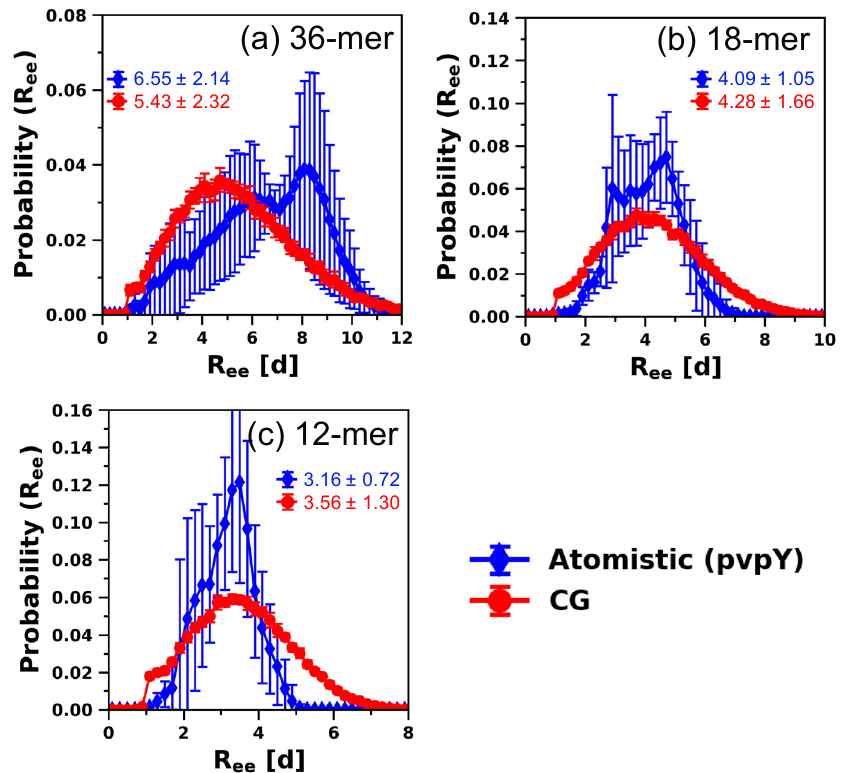
Figure 7. Comparison of distributions of R ee distance (with ensemble average values in reduced units (d)) for ( a ) 36-mer, ( b ) 18-mer, and ( c ) 12-mer pvpY chains, obtained from atomistic simulations and CG simulations (for the best performing case of attractive interaction between any two backbone beads (B–B), ε BB , in the CG model equal to 0.7 kT and B–B´–B´´–B´´´ and H–B–B´–H´ torsional constraints simultaneously imposed). The standard deviations are computed from the means of 5 independent trials for atomistic simulations and 10 independent trials for CG simulations and the lines joining the symbols in are drawn to guide the eye.